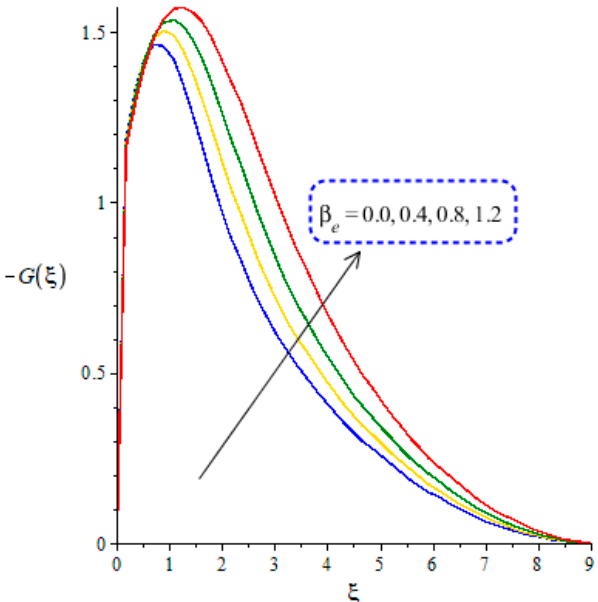
Figure 7. Variation role of − G ( ξ ) versus F r when m = 0.7, We = 4.0, Ω = 2.3, M 2 = 0.3, β i = 0.2, Figure 7. Variation role of −𝐺(𝜉) versus 𝐹 (cid:3045) when 𝑚 = 0.7, 𝑊𝑒 = 4.0, Ω = 2.3, 𝑀 (cid:2870) = 0.3, 𝛽 (cid:3036) = (cid:101) = 0.1, F r = 2.7, Pr = 204, Ec = 0.14, ϕ 2 = 0.0075, ϕ 1 = 0.002, ϕ 3 =